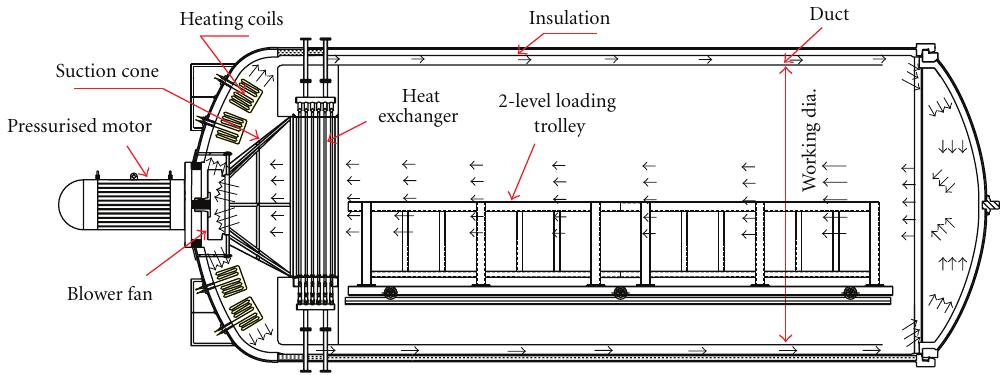
Figure 5: Schematic of air circulation and heating